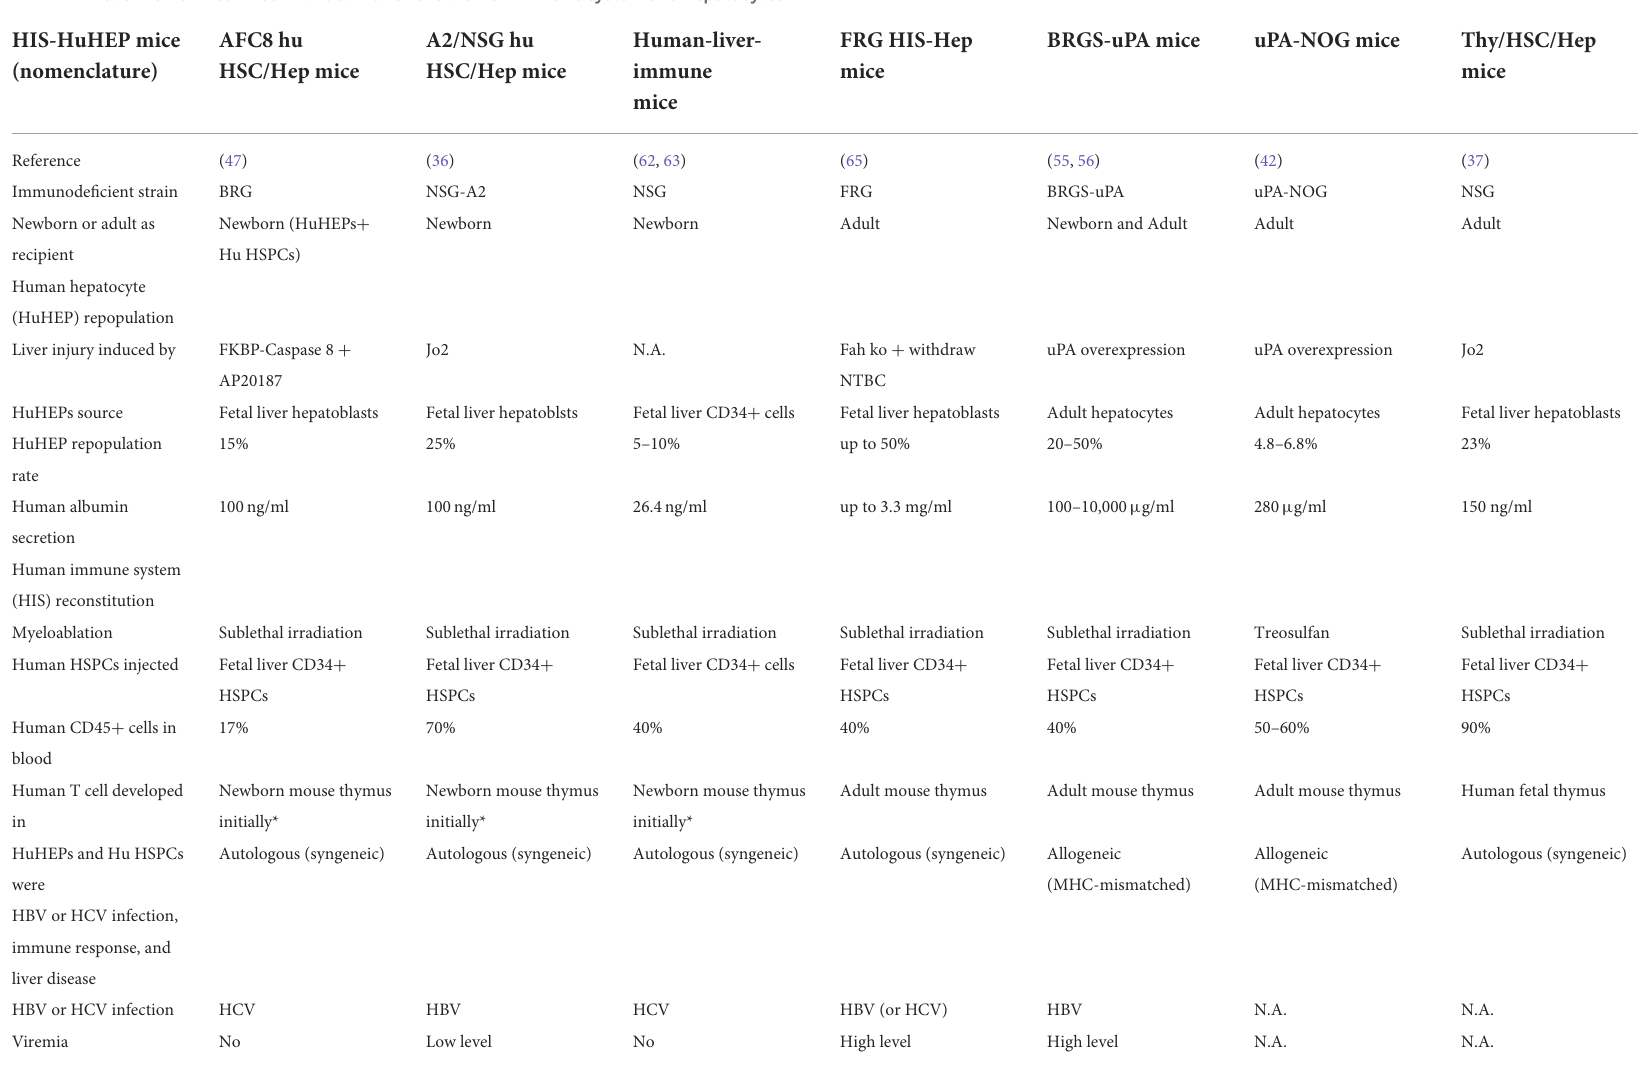
TABLE 1 List of humanized mice with both functional human immune system and